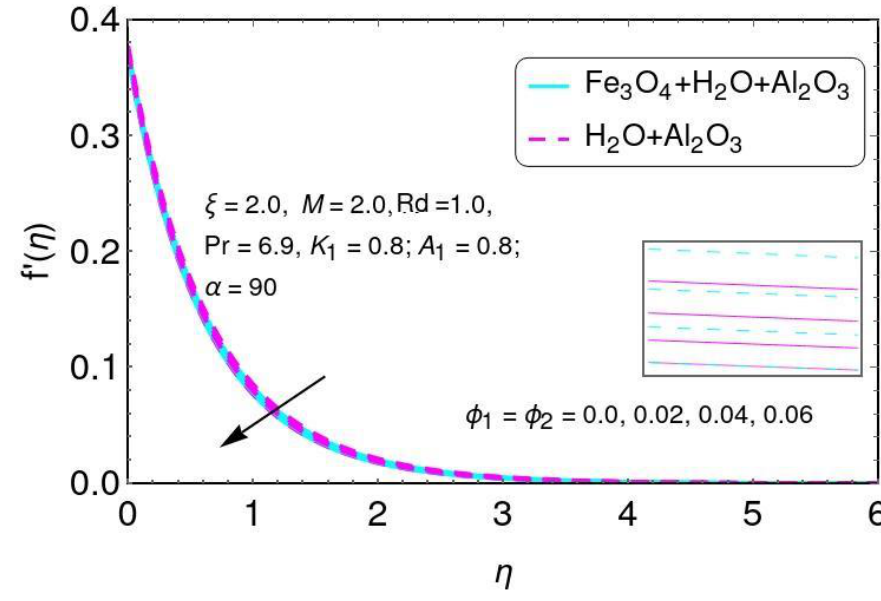
Figure 8. The distribution of f (cid:48) ( η ) for φ 1 , φ 2 .